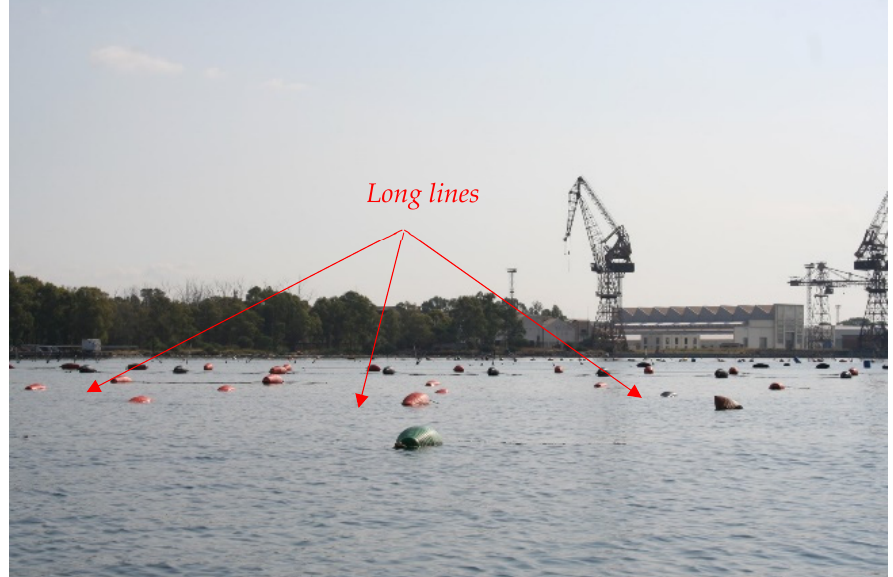
Figure 3. Floating systems of mussel farms called “long lines” where the plastic buoys are clearly visible (in the background, a former shipyard is visible) in the first inlet of Mar Piccolo ( Puglia Region ). May 2018.